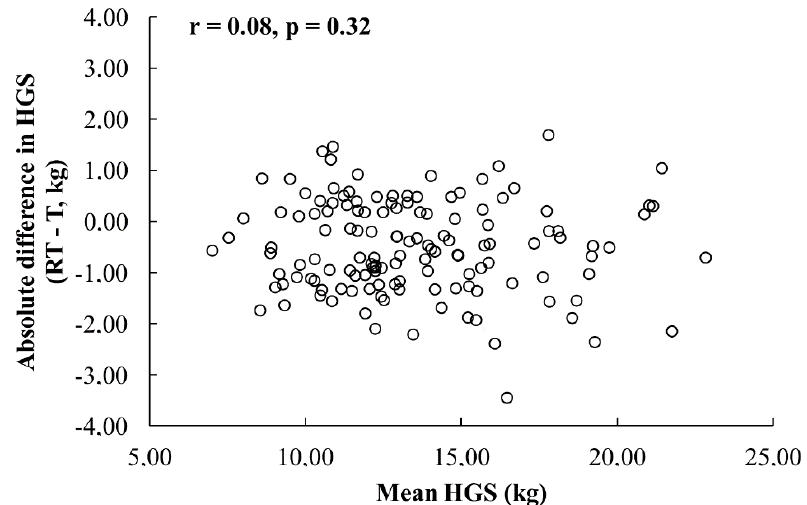
Figure 1. Pearson ’ s correlation coefficients of the absolute difference between the test and retest and Figure 1. Pearson’s correlation coe ffi cients of the absolute di ff erence between the test and retest and the mean of the test and retest for the dominant hand in 7 – 9 years age group (T — test, RT — retest). the mean of the test and retest for the dominant hand in 7–9 years age group (T—test, RT—retest). Int. J. Environ. Res. Public Health 2020 , 17 , x